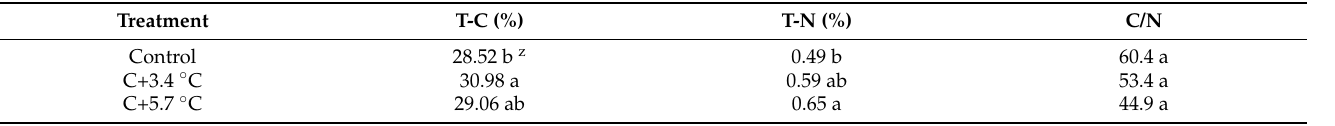
Figure 5. Flowering of peach trees grown under different temperatures and a carbon dioxide concentration of 700 μ mol·mol − 1 on April 10, 2020. Left, Control; Middle, C+3.4 °C; Right, C+5.7 °C. The total carbohydrate and nitrogen contents of first-year shoots were analyzed, and the C/N ratio was calculated. Total carbohydrate content was the highest in the C+3.4 °C treatment, followed by the C+5.7 °C treatment and control. Furthermore, the nitrogen con- tent increased as the temperature increased, and that of the C+5.7 °C treatment was the highest at 0.65%. There was no significant difference in the C/N ratio, but it decreased as the temperature increased, and the C/N ratio of the C+5.7 °C treatment was the lowest at 44.9% (Table 5). Table 5. Carbon and nitrogen concentrations and C/N ratios of 1-year-old ‘Mihong’ peach shoots affected by elevated temperatures under a carbon dioxide concentration of 700 μ mol·mol − 1 .